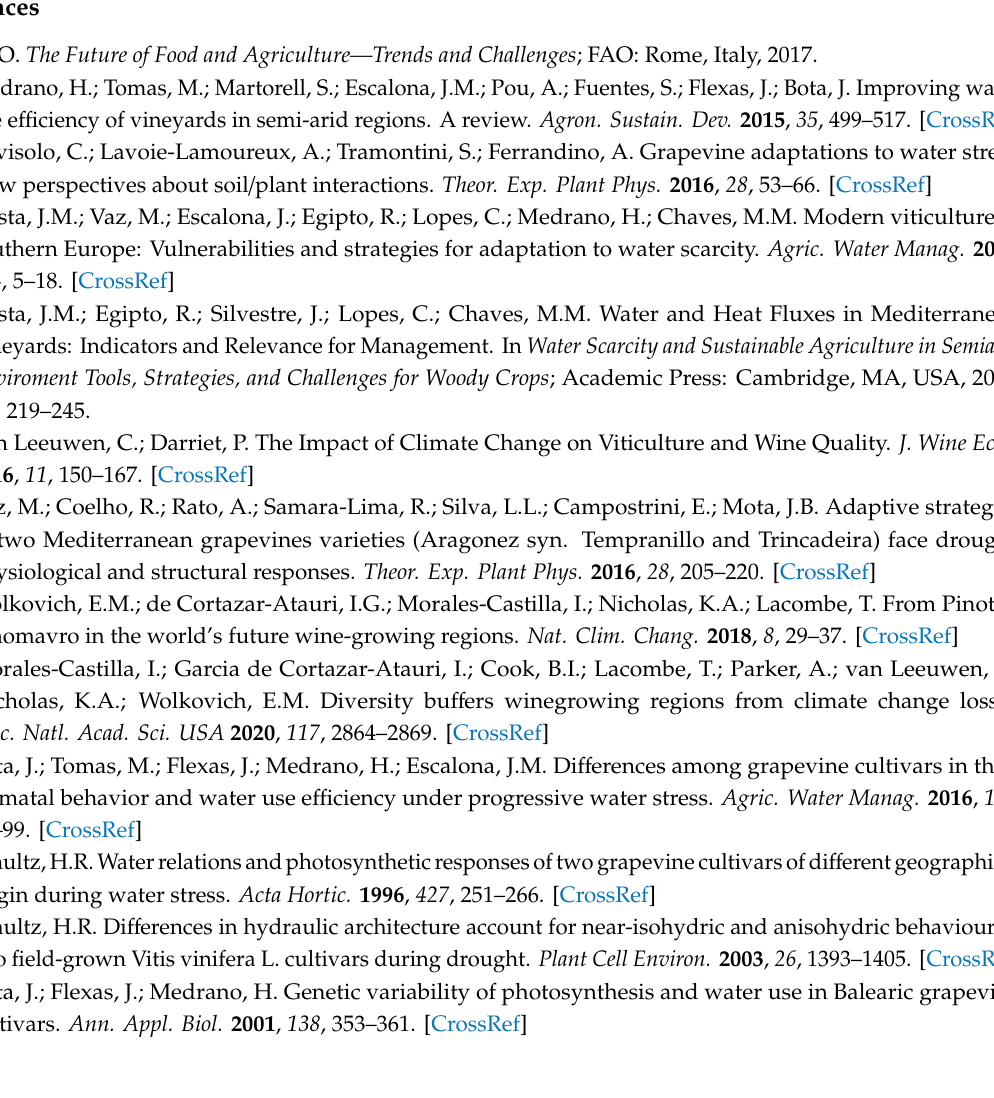
Table S1 : Overview of the metabolite reporting list; Table S2 : p -values associated with the factors cultivar, treatment and its interaction from the univariant Analysis of Variance (ANOVA); Table S3 : Relative metabolite levels in leaves of all grapevine cultivars under well-watered (WW) and water deficit stress (WDS) conditions; Table S4 : Factor loadings of the Principal components (PC) Analysis; Table S5 : Pearson correlation coe ffi cients between metabolite levels and physiological parameters in red cultivars under water deficit stress; Table S6 : Pearson correlation coe ffi cients between metabolite levels and physiological parameters in white cultivars under water stress. Table S7 : Whole data set including all the individual replicates for all metabolites and physiological parameters